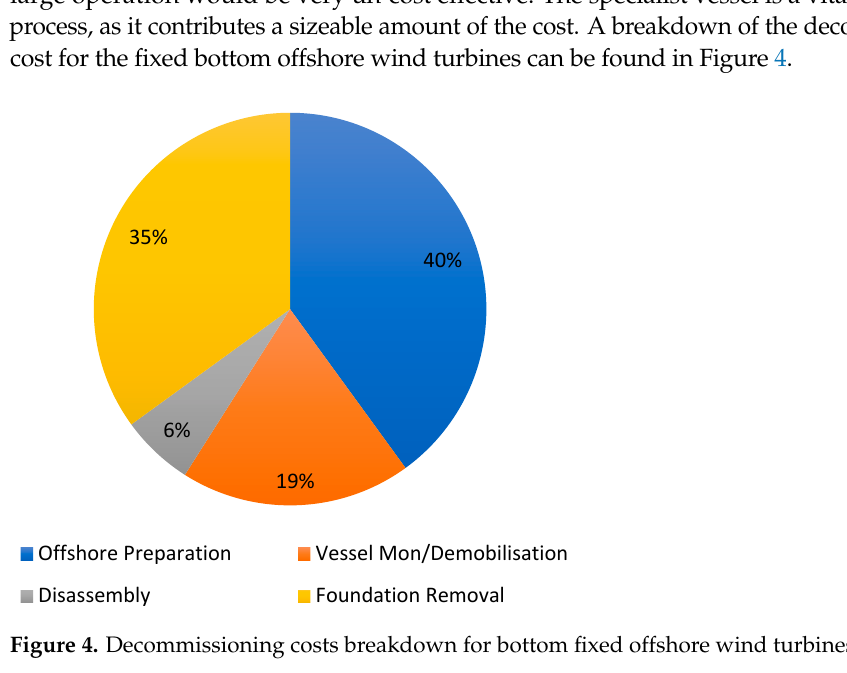
Table 2. Summary table of the decommissioning [34].